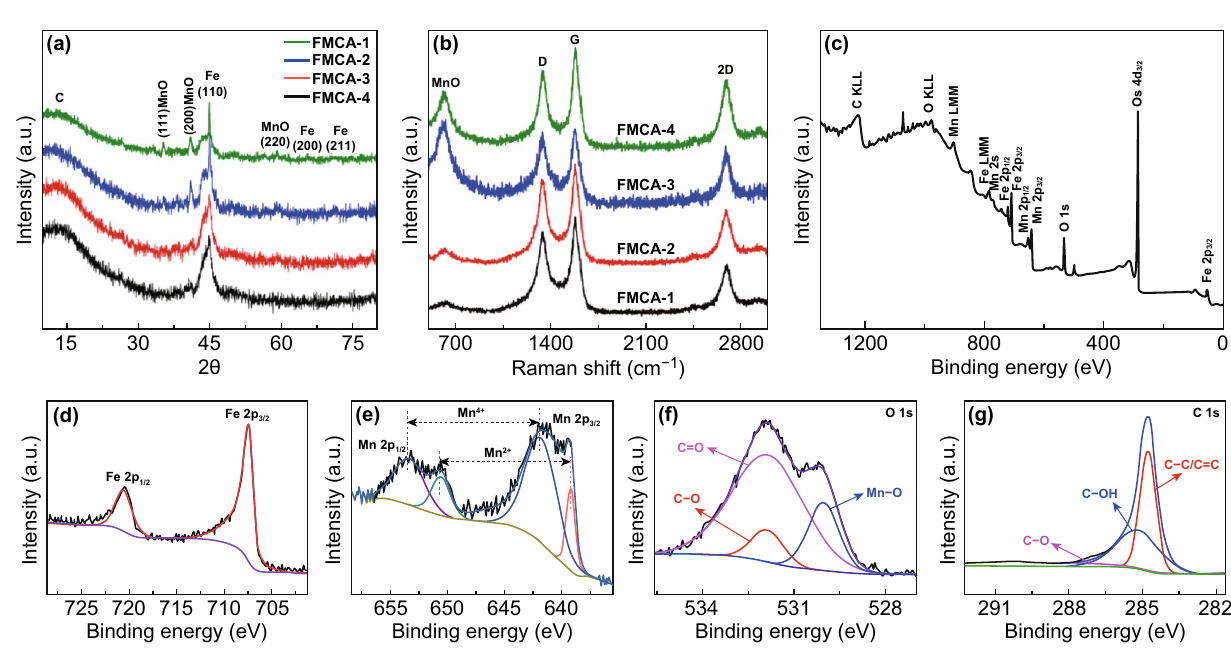
Fig. 3 a XRD patterns of FMCA. b Raman spectrum of FMCA-3. c survey XPS of FMCA-3. d Fe 2 p , e Mn 2 p , f O 1s, and g C 1s spectra of